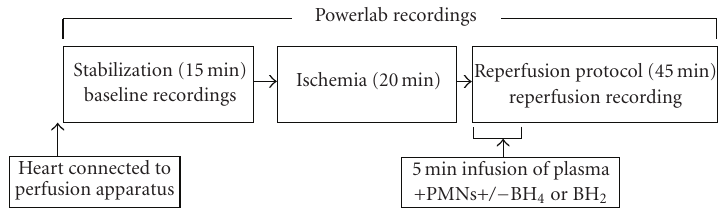
Figure 1: Schematic diagram of the ischemia/reperfusion protocol in the isolated perfused rat heart model.